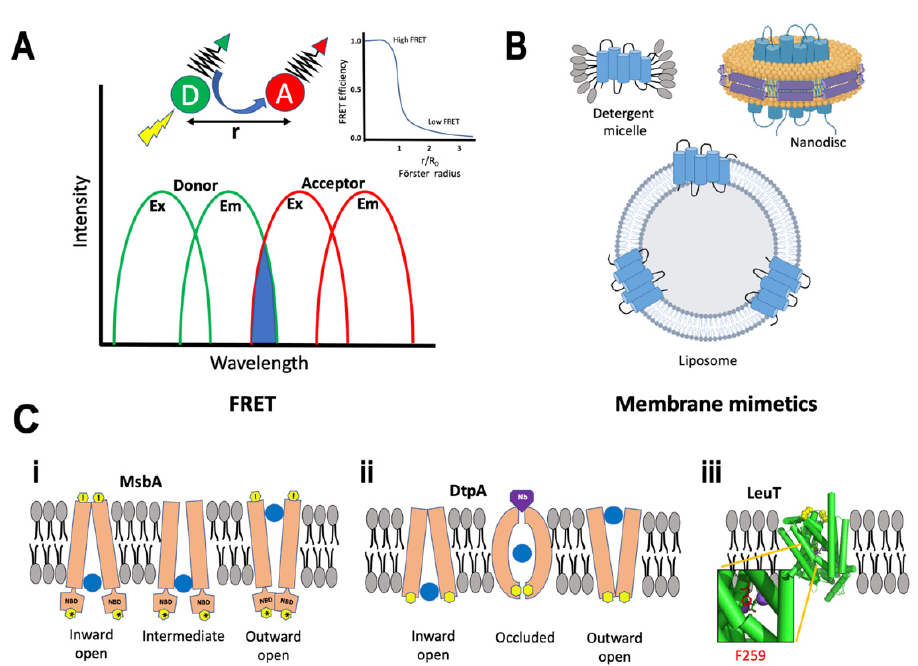
Figure 4. ( A ) Schematic showing the overlap of the donor emission and acceptor excitation spectra leading to the observation of FRET. Additionally shown in inset is the effect of R 0 on FRET intensity. ( B ) Different membrane mimicking systems available for in vitro reconstitution of membrane protein for FRET studies. Nanodisc image was generated using BioRender. ( C ) The different conforma- tional intermediates occupied by MsbA (i) and DtpA (ii) during the transport of substrate